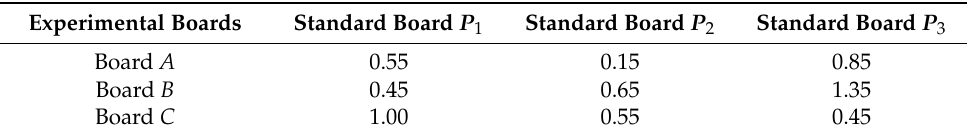
Table 5. The Hamming distance between the experimental boards and standard boards.